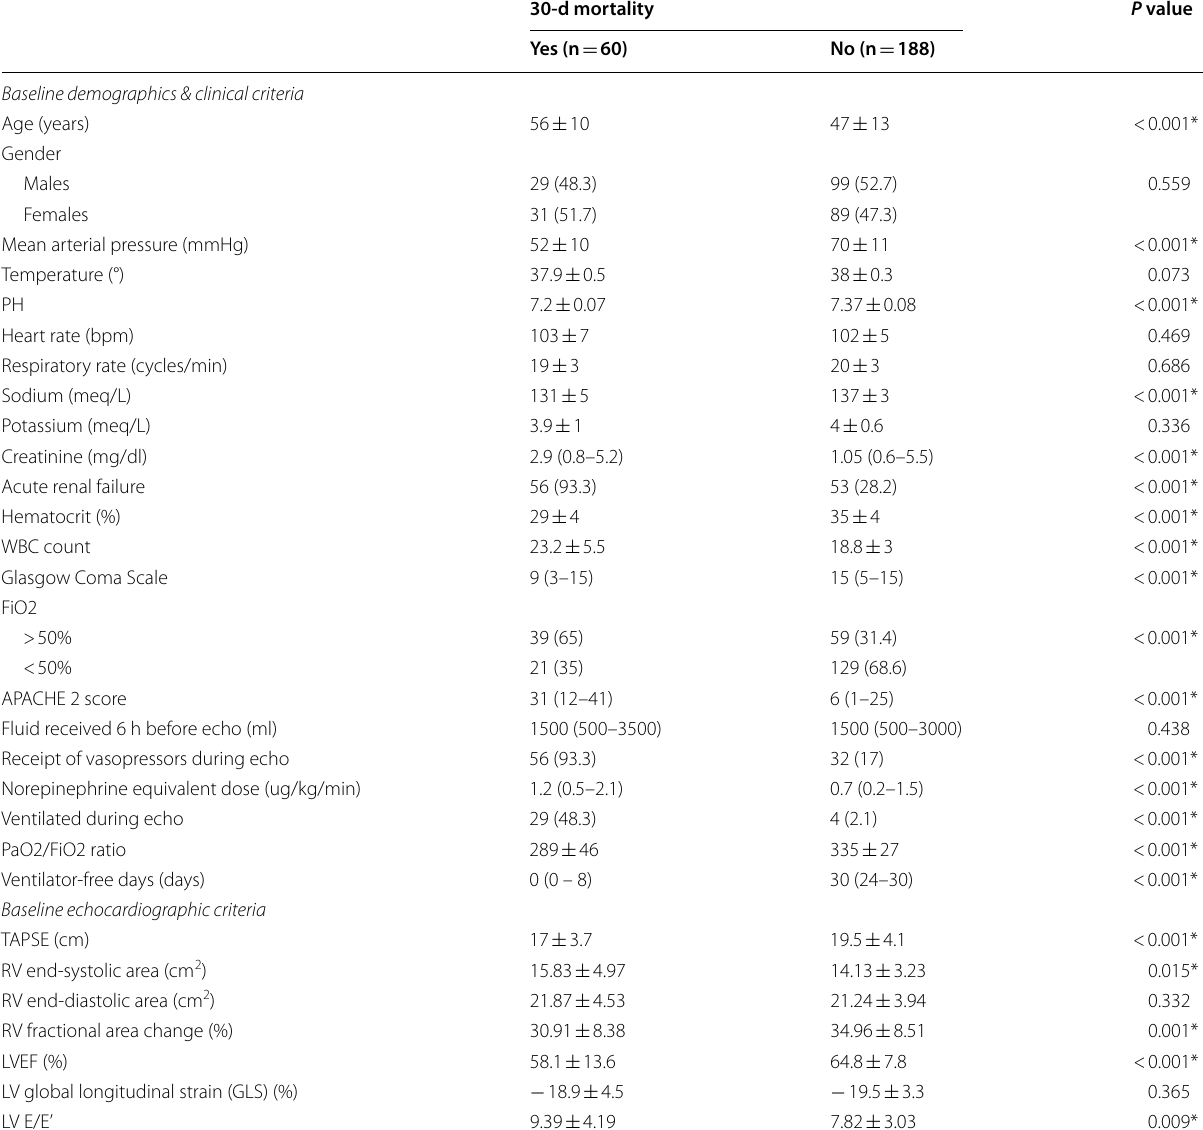
Table 1 Demographics, clinical, and echocardiographic characteristics stratified by vital status at